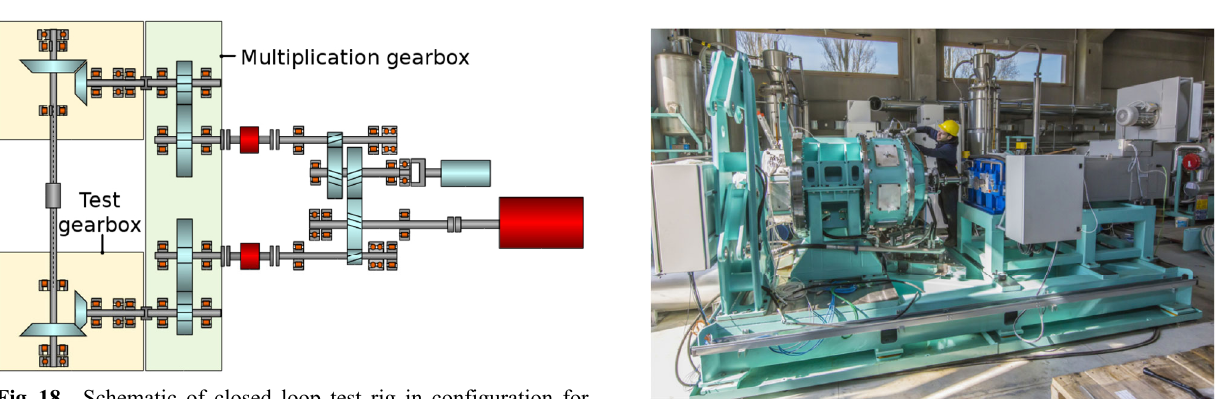
Fig. 18 Schematic of closed loop test rig in configuration for testing bevel gears. Fig. 19 Image of planetary gear test rig.